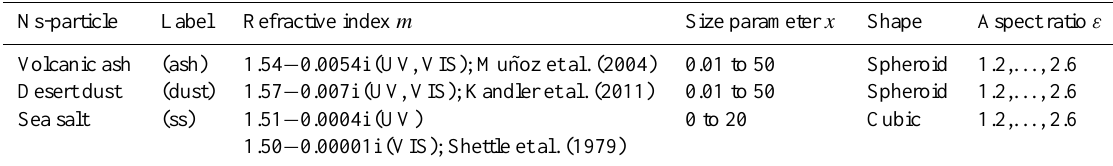
Table 2. Input parameters used in the numerical T-matrix simulation on ns-particles (ash, dust, sea salt): m-complex refractive index at the lidar wavelengths (UV, λ 1 =355nm; VIS, λ 2 =532nm), size parameter range, modelled shape, aspect ratios values and literature reference for the m refractive index. The discrete set of x values is x =0.01, 0.02, 0.1, 0.25, 0.5, 1; step of 1 for x =1 to 10, step of 2 for x =10 to 30, 35, 40, then 45, 50. For ε values, the step is